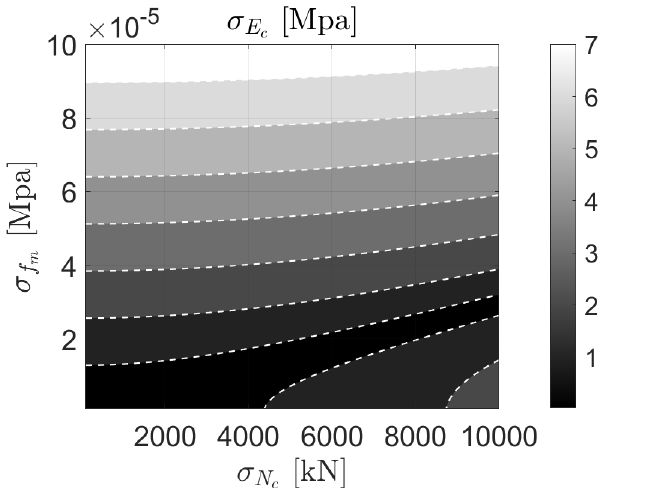
Figure 6. Variance of the elastic modulus associated with the variances of prestressing and the first natural frequency, ranging between 0–10,000 kN and 10 − 5 –10 − 4 MPa,